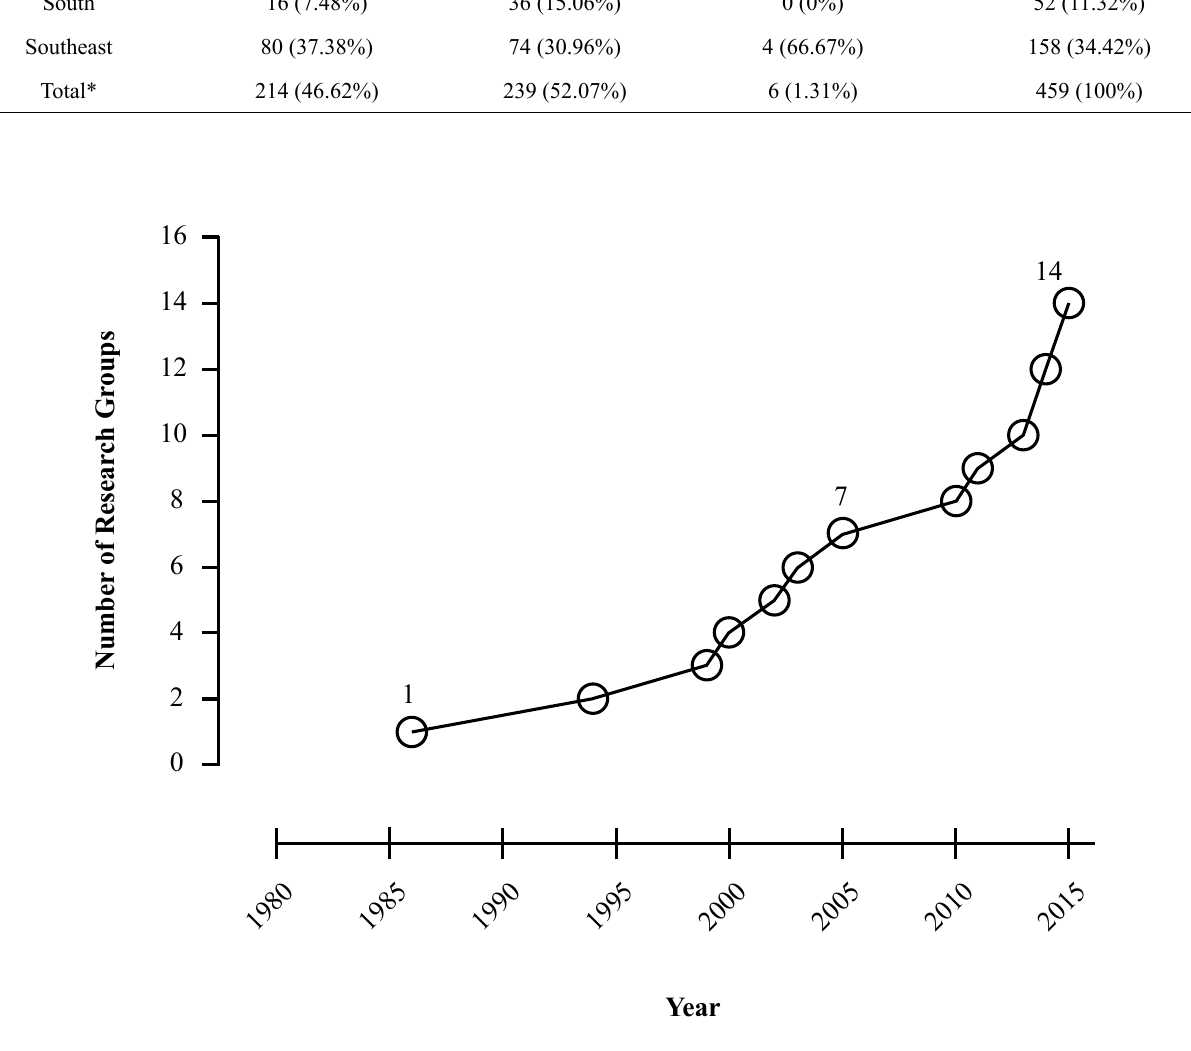
Table 2. Distribution of academic titles of the research group leaders by Brazilian region Region